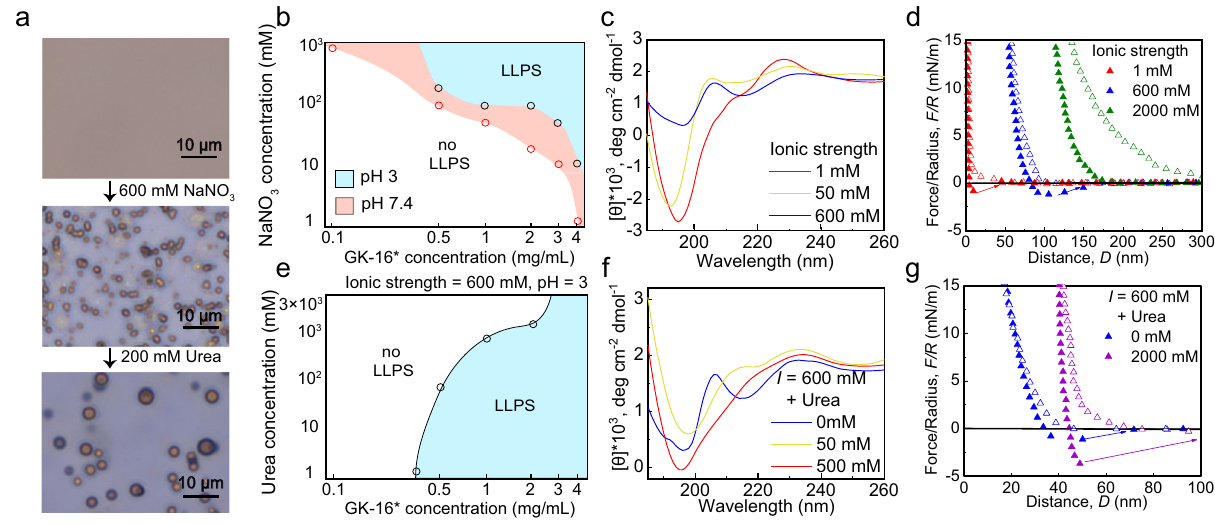
Fig. 2 | LLPS of GK-16*. a By adding salt and urea, GK-16* forms coacervates with tunable morphologies. Three experiments were repeated independently with similar results. b Phase diagram of GK-16* with different peptide and salt concentrations at pH 3 and 7.4. c CD spectra of GK-16* (1mg/mL) in solutions with different ionic strengths. d SFAforce-distancepro fi lesofGK-16*(2mg/mL)insolutionswithdifferent